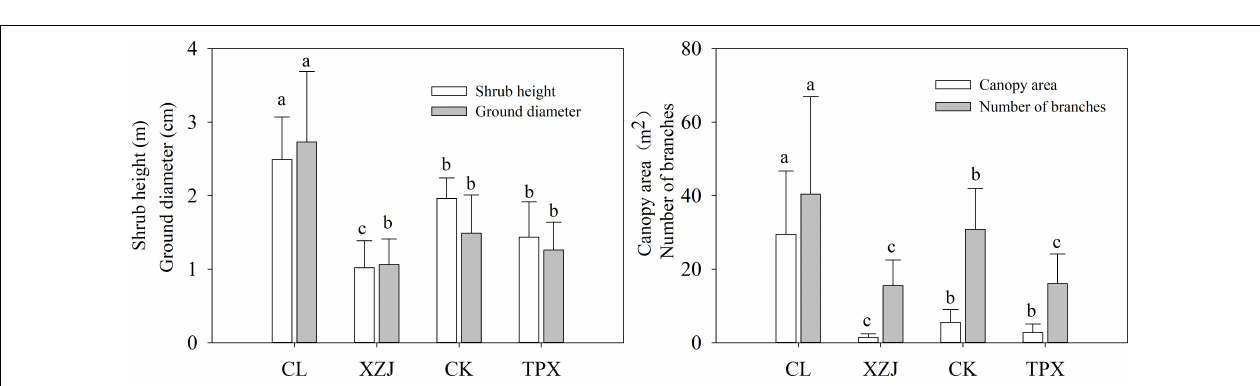
FIGURE 3 | Shrub height, ground diameter, canopy area, and number of branches. Values shown are mean ± SD. Bars for a given parameter are labeled with different letters representing reach significance level at each sampling site (one-way ANOVA, p < 0.05).